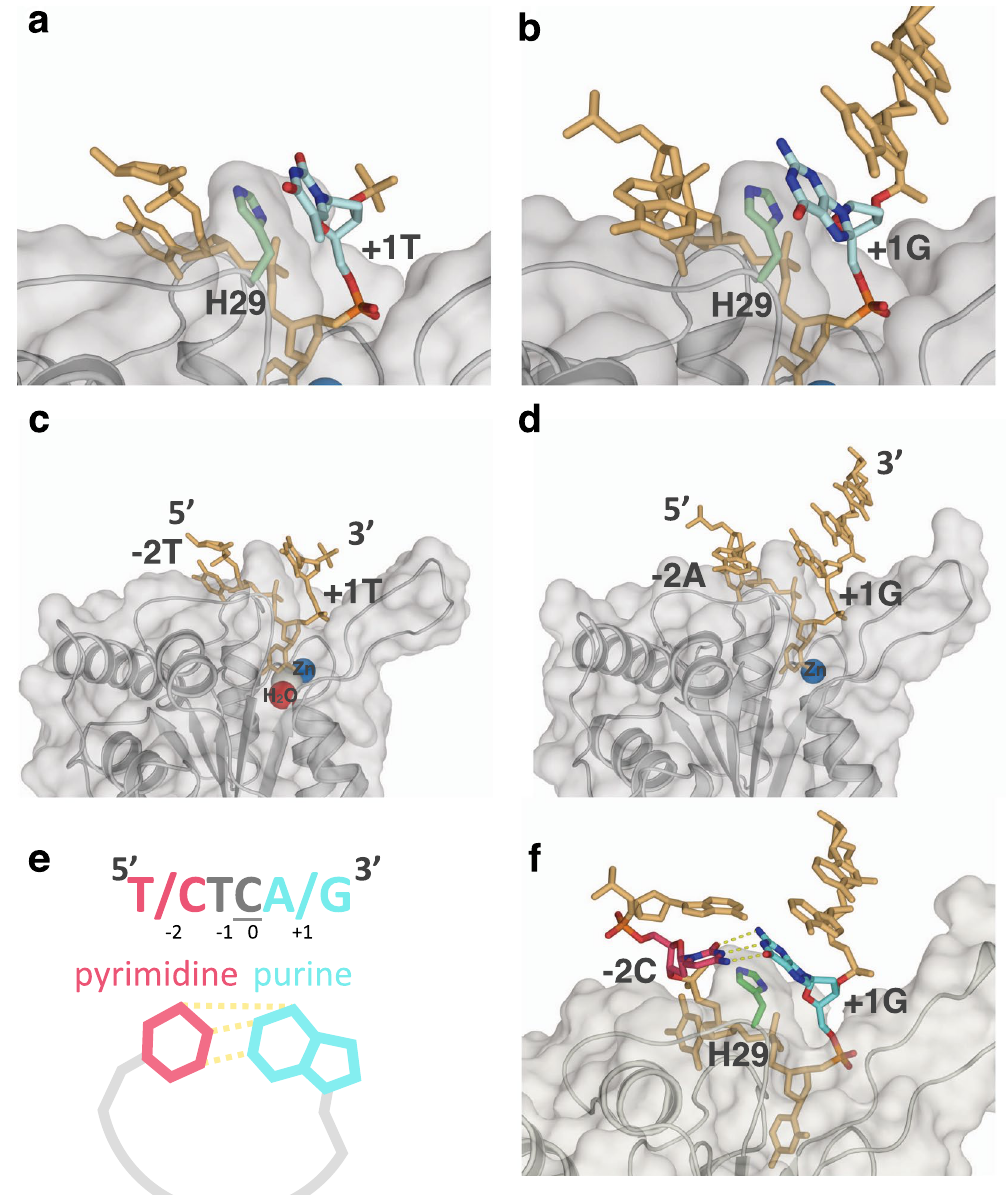
Figure 5. ssDNA is bent within the complex with A3A. Crystal structure of A3A shown in surface and cartoon representation (gray) bound to ssDNA displayed as orange sticks; ( a ) + 1 thymidine (light blue) is interacting with His29 (light green sticks) through aromatic stacking (PDB ID: 5KEG) ( b) + 1 guanine (light blue) also interacting with His29 through aromatic stacking (light green sticks) (PDB ID: 5SWW). ( c) A3A(E72A/ C171A) with TTTTTTTTCTTTTTT (PDB ID: 5KEG) ( d ) A3A(E72A) with AAAAAAATCGGGAAA (PDB ID: 5SWW). Other nucleotides are shown as orange sticks, while water (red), zinc (blue), and chloride (gray) in the active site are shown as spheres. Nitrogen and oxygen of residues and nucleic acids are in blue and red respectively. ( e) A schematic of hydrogen bonding between pyrimidine (pink) at − 2 and purine (light blue) at + 1 position via bending of the DNA by A3A upon binding. ( f) Model of inter-DNA base interactions through binding of A3A to ssDNA. A3A(E72A)–ssDNA complex (PDB ID: 5SWW) was used to model A3A signature sequence CTCG bound at the active site. A3A is shown as gray surface and cartoon, His29 as light green sticks, original ssDNA as orange sticks with + 1 G in light blue. Adenosine at − 1 position was switched to cytosine (pink) with hydrogen bonds to + 1 G displayed as yellow